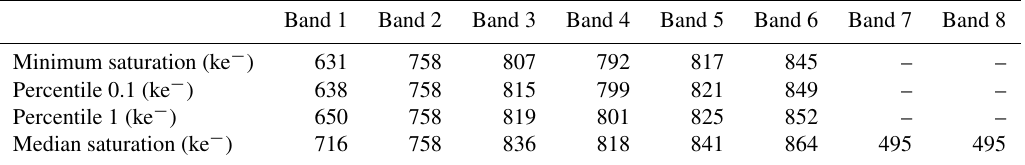
Table 3. The UVN saturation thresholds, measured in electrons, as obtained from unbinned measurements. Shown here are the minimum and three percentiles of the set of pixels that become directly saturated. Signal values above these thresholds should be flagged as “saturated” by the L01b processor; signal values below these thresholds can safely be regarded as behaving linearly, unless saturation occurs in neighbouring pixels.